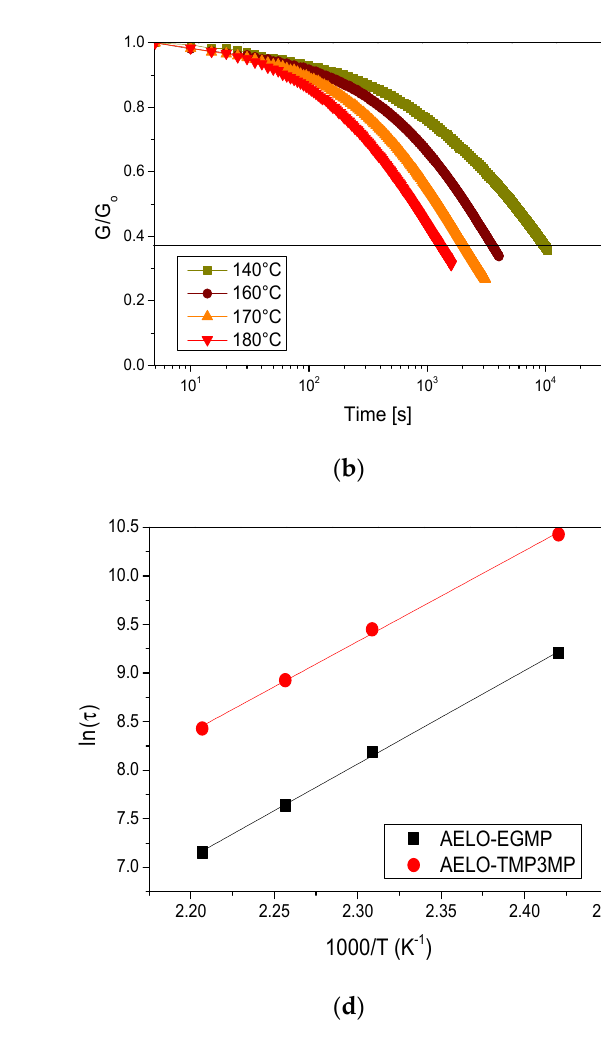
Figure 4. ( a ) Time-dependent relaxation modulus data recorded at 180 °C for AELO-TMP3MP and AELO-EGMP networks. Time-dependent relaxation modulus of ( b ) AELO-EGMP and ( c ) AELO-TMP3MP networks recorded at a temperature range between 140 and 180 °C. ( d ) Arrhenius plots of AELO-EGMP and AELO-TMP3MP confirming the linear dependency, which is characteristic for dynamic polymer networks following an associative bond exchange mechanism.